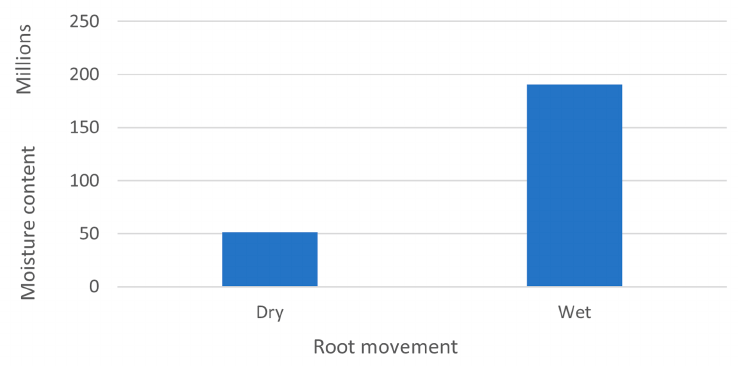
Figure 2. Water-dependent movement of roots (hydrotropism).